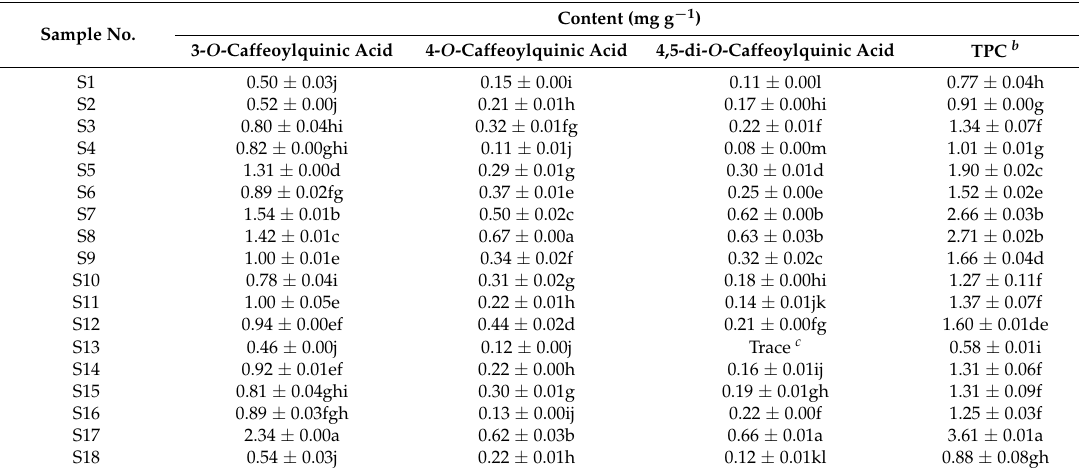
a Data are expressed as mean ± SD of duplicate experiments. Different letters indicate significant differences among the C. paliurus from different geographic regions in phenolic acid content ( p ≤ 0.05 by Duncan’s test); b TPC: contents of total three phenolic acids; c Trace: under quantification limit